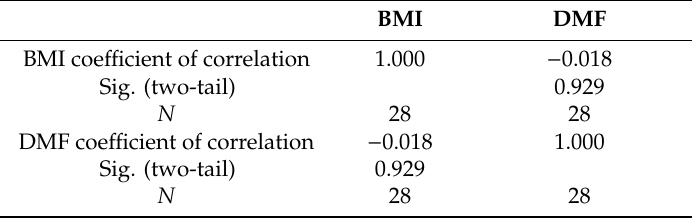
Table 11. Data related to the correlation between BMI and DMF evaluated in overweight patients.